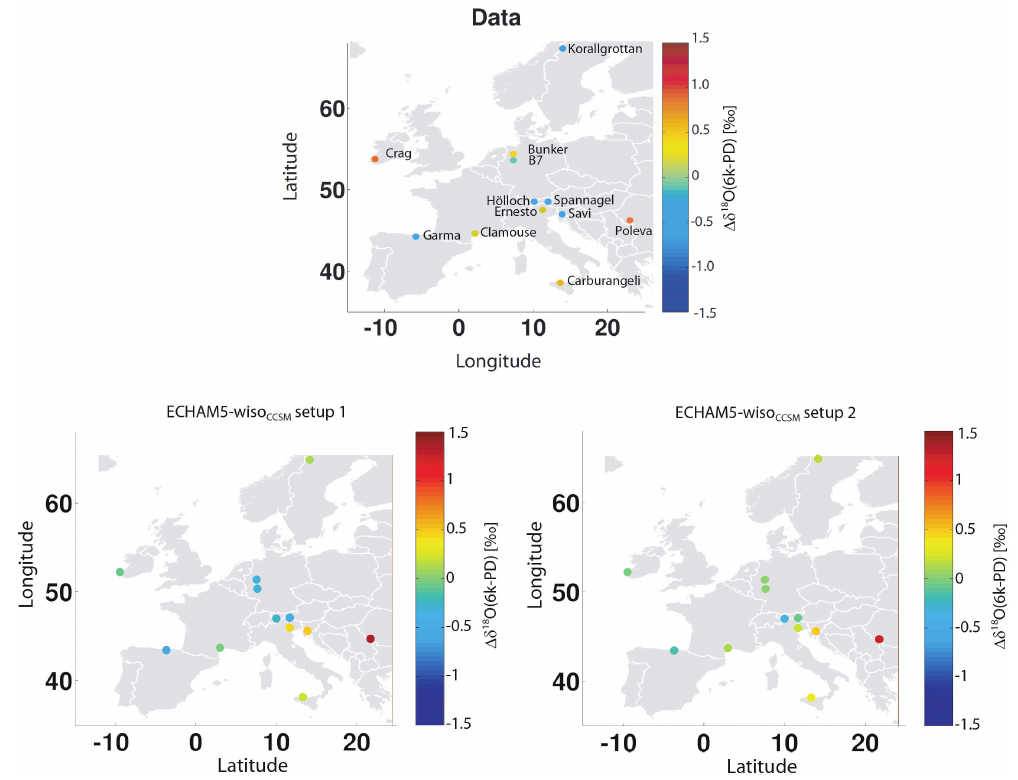
Fig. 7. δ 18 O calcite difference 6k-PD in Europe: (a) measured stalagmite date, (b) and (c) simulated by ECHAM5-wiso coupled with CCSM using two different setups for calculating the amount of evaporation (setup 1 “ECHAM” and setup 2 “Thorntwaite”). The coloured dots represent the cave locations and respective value for δ 18 O calcite (6k-PD) according to the given colour